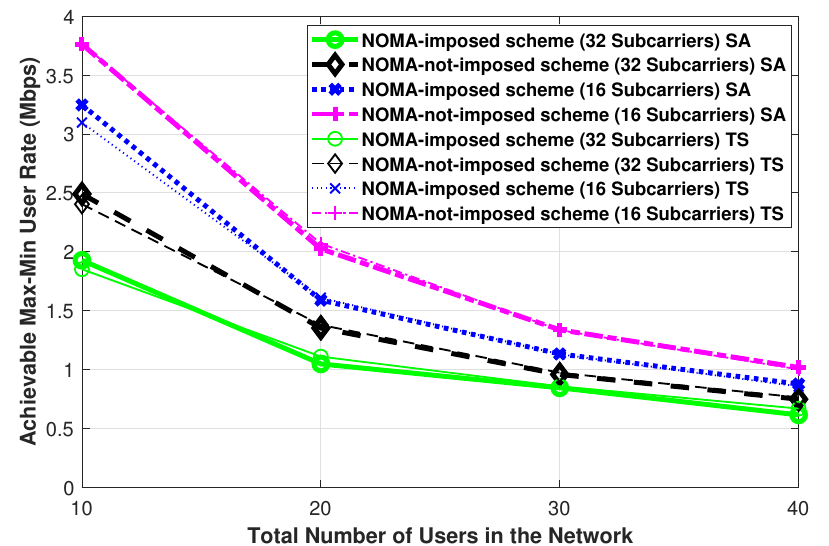
Figure 3. The achievable max-min user rate validation curve between the simulated annealing and the Tabu-search algorithms for both the NOMA-imposed scheme and the NOMA-not-imposed scheme obtained while changing the total number of users in the network. ( P e = 35 dBm, L = 4, φ 1/2 = 60 ◦ , Ψ 1/2 = 85 ◦ ).